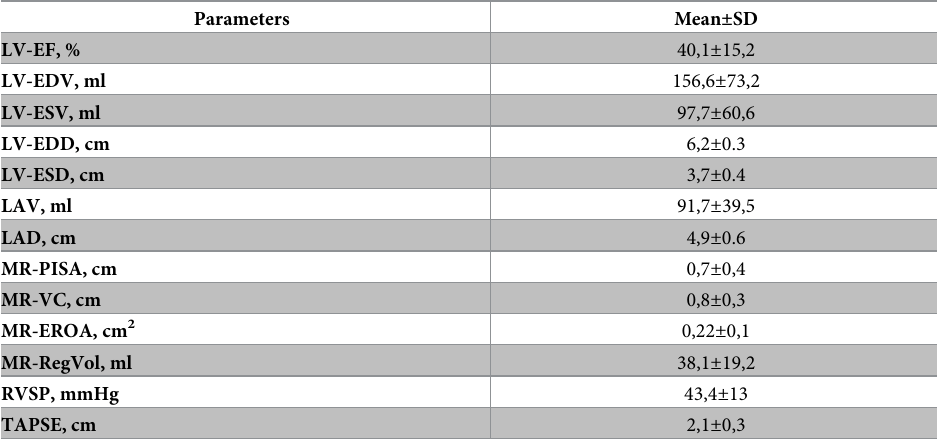
Table 2. Echocardiographic characteristics (N = 105).